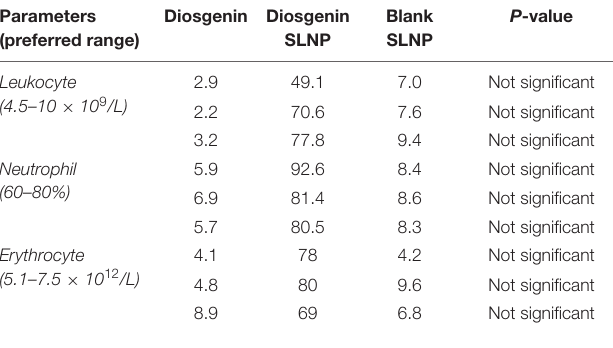
TABLE 2 | Blood complete profile of different mice group shows level of different cell count (leukocyte count, neutrophil count, and erythrocyte count) after treatment with diosgenin, diosgenin SLNP, and blank SLNP for toxicity